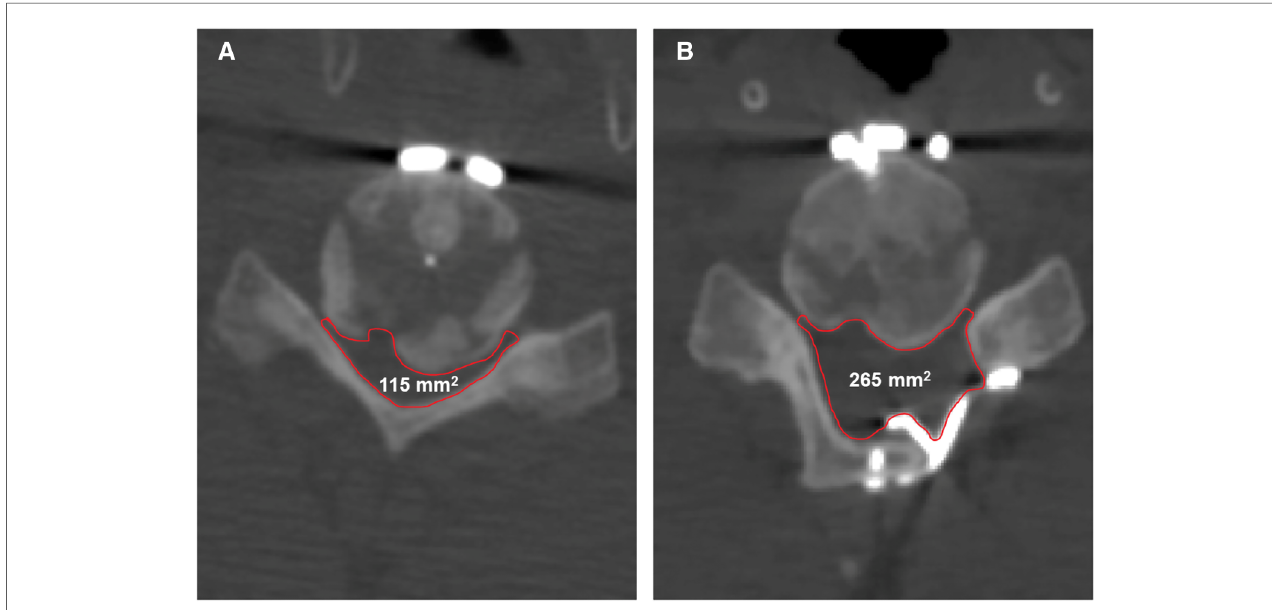
FIGURE 4 The changes in the space in the spinal canal from preoperative to postoperative. ( A ) The preoperative space in the spinal canal at the C5/6 level is 115 mm 2 . ( B ) The postoperative space of the spinal canal at the C5/6 level is 265 mm 2